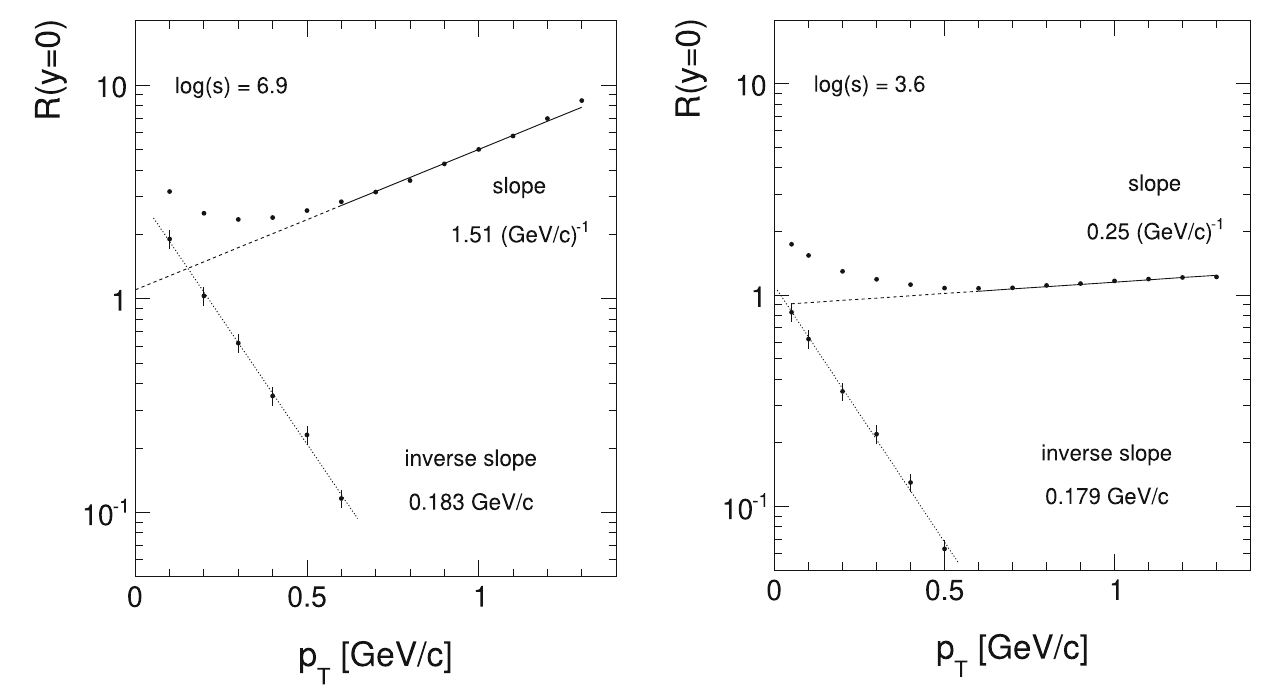
Fig. 125 R ( y = 0 , s , p T ) as a function of p T for log ( s ) = 3.6 with exponential fit to p T > 0.6 GeV/c, extrapolation to low p T (broken line) and subtracted ratio (dotted